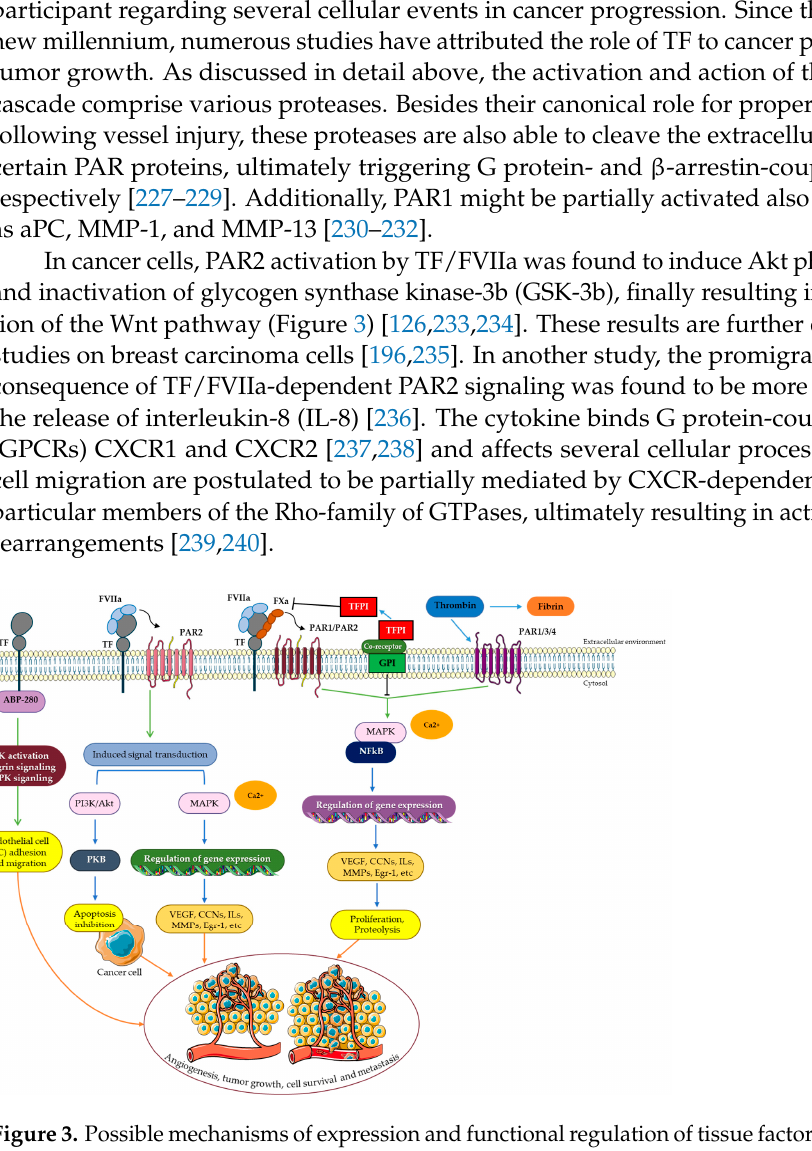
servier.com/ (accessed on 16 May